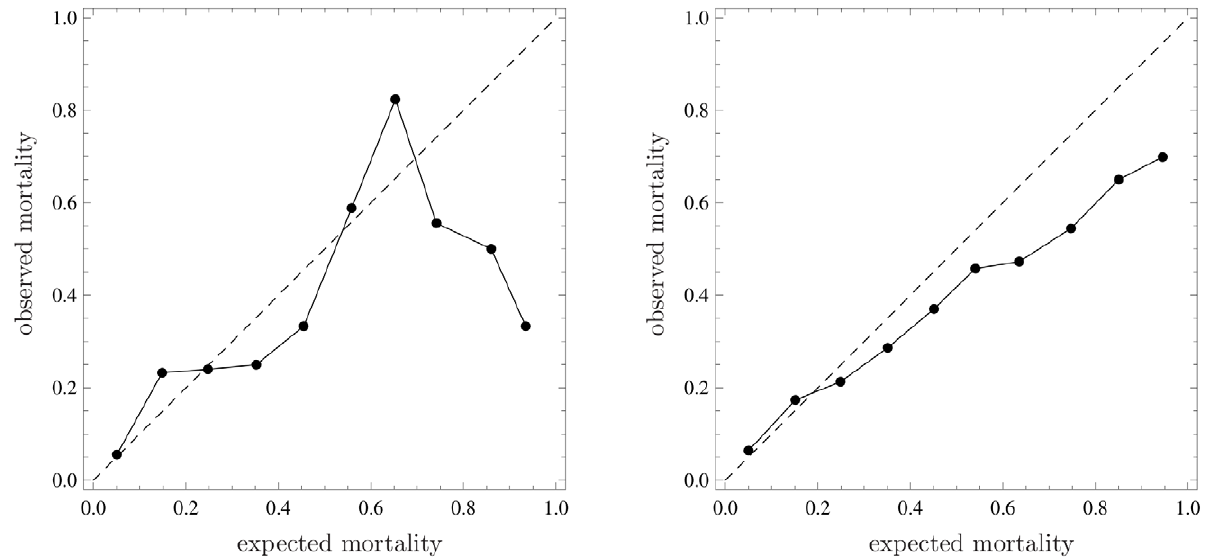
Figure 1. Calibration plots through representation of observed mortality versus expected mortality (bisector, dashedline ). Left panel: Data of 194 patients staying longer than 24 hours in a single Intensive Care Unit (ICU) taking part in GiViTI (Italian Group for the Evaluation of Interventions in Intensive Care Medicine) in 2008; expected mortality calculated with a prediction model developed by GiViTI in 2008. Right panel: Data of 2644 critically ill patients admitted to 103 ICUs in Italy from January to March 2007; expected mortality calculated with SAPS II.